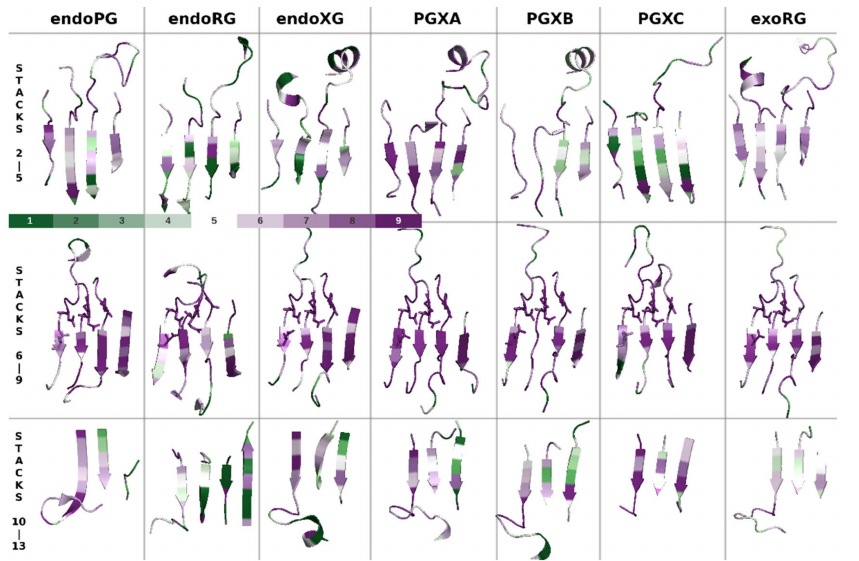
Figure 5. Consurf conservation analysis shows different conservation patterns for different GH28 subfamilies. Shown are selected regions that cover PB1, with some adjacent loop regions, of, in columns, structures 1CZF (endoPG), 1RMG (endoRG) and 4C2L (endoXG), as well as Alphafold structure models for PGLRX_ASPFU ( PGXA ), Q7SAI8_NEUCR ( PGXB ), A0A1L9N956_ASPTC ( PGXC ) and A0A194WYS5_9HELO ( exoRG ) aligned to 1CZF. In rows are shown the N-terminal, central and C-terminal regions, conceptually corresponding to subsites − 5 to − 2, the site with subsite − 1 and +1 and subsite +2 and +3, for each of the seven subfamilies. The color scale indicates levels of conservation, 1 being low and 9 being